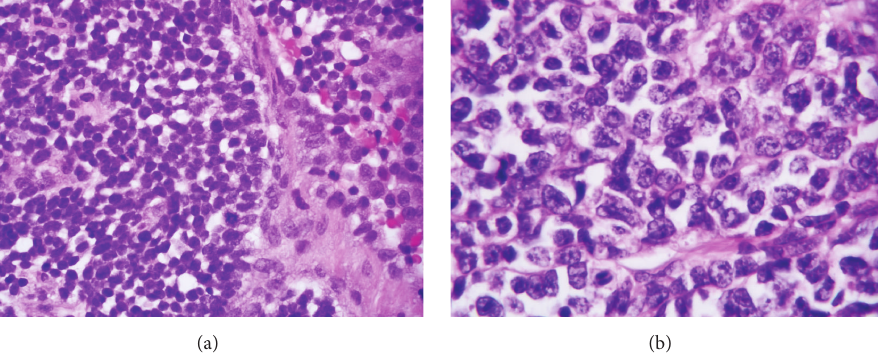
Figure 3: (a) The small round cell population arranged in nests of cells with scant cytoplasm and slightly irregular nuclei, × 600. (b) Small cell component with scant cytoplasm and hyperchromatic nuclei containing distinct nucleoli, × 1000.